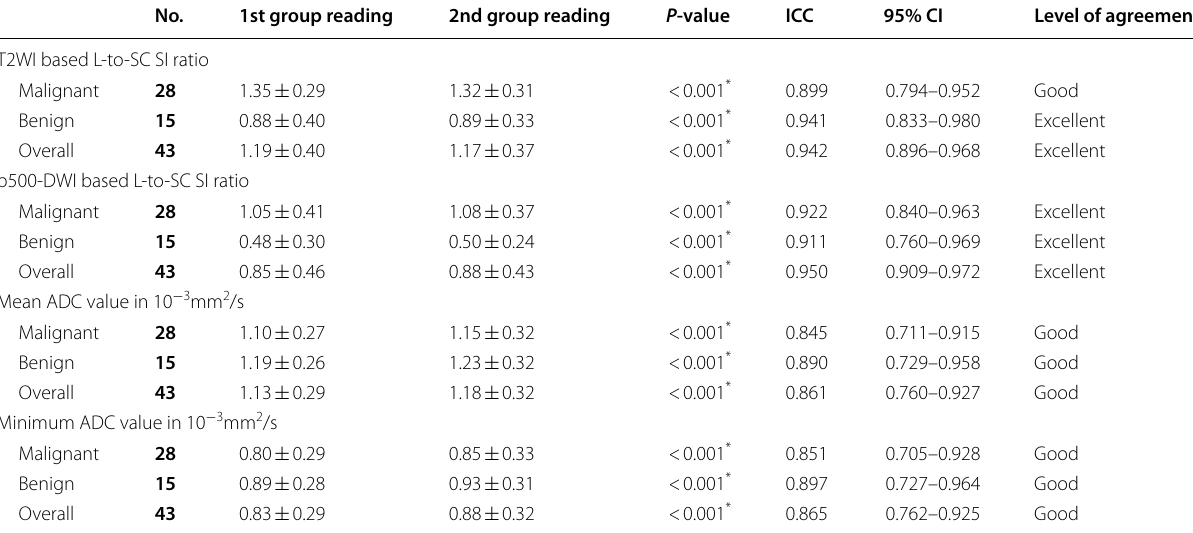
Table 1 Inter-rater reliability and intra-class correlation coefficient (ICC)